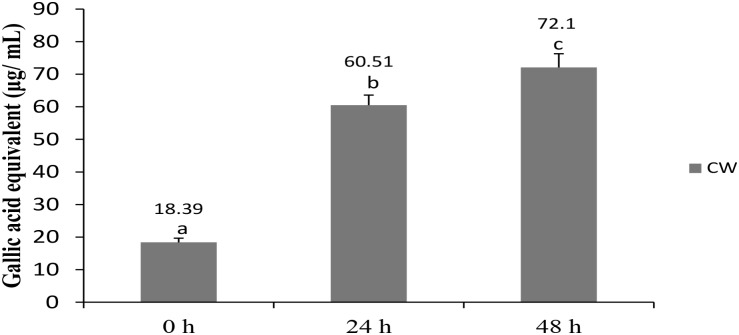
Total phenolic content in CW fermented by L. casei L4. Results are expressed as mean ± SD (n = 3). Different letter above the bar indicate significant difference (p < 0.05).